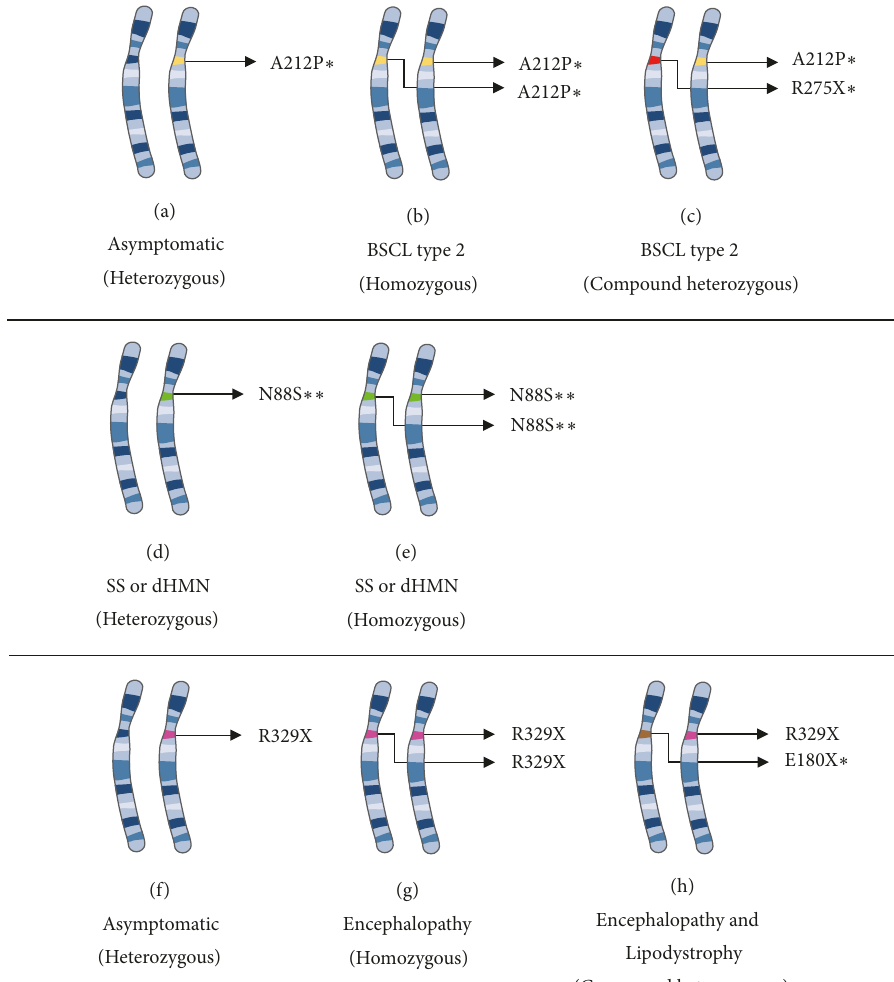
Figure 7: Inheritance pattern of seipin-related diseases. Here, we summarize the inheritance mechanism of seipin-related diseases. (a–c) BSCL type 2, a loss-of-function, and recessive disease. (d-e) Seipinopathies, gain-of-function, and dominant diseases. (f–h) Progressive encephalopathy with or without lipodystrophy (PELD) and a gain-of-function and recessive disease. Pieces of the illustrations are from the SMART website [40]. ∗ Or other mutations related to BSCL type 2. ∗∗ Or other mutations related to seipinopathy. BSCL: Berardinelli-Seip congenital lipodystrophy; dHMN: distal hereditary motor neuropathies; SS: Silver